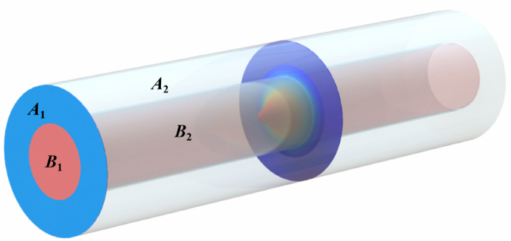
Figure 3. Calculation of the fractional power inside the fiber. A 1 and B 1 refer to the plane of core and cladding, respectively. A 2 and B 2 refer to the volume of liquid and core,